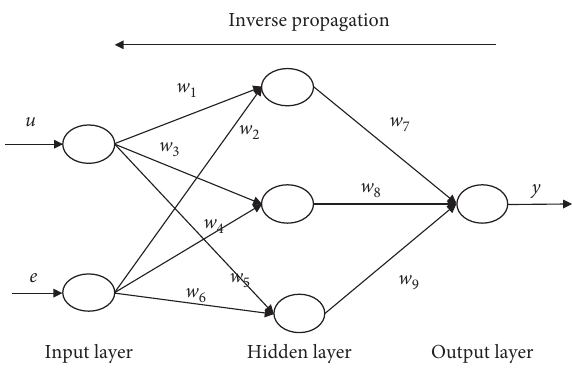
Figure 1: Structure of a